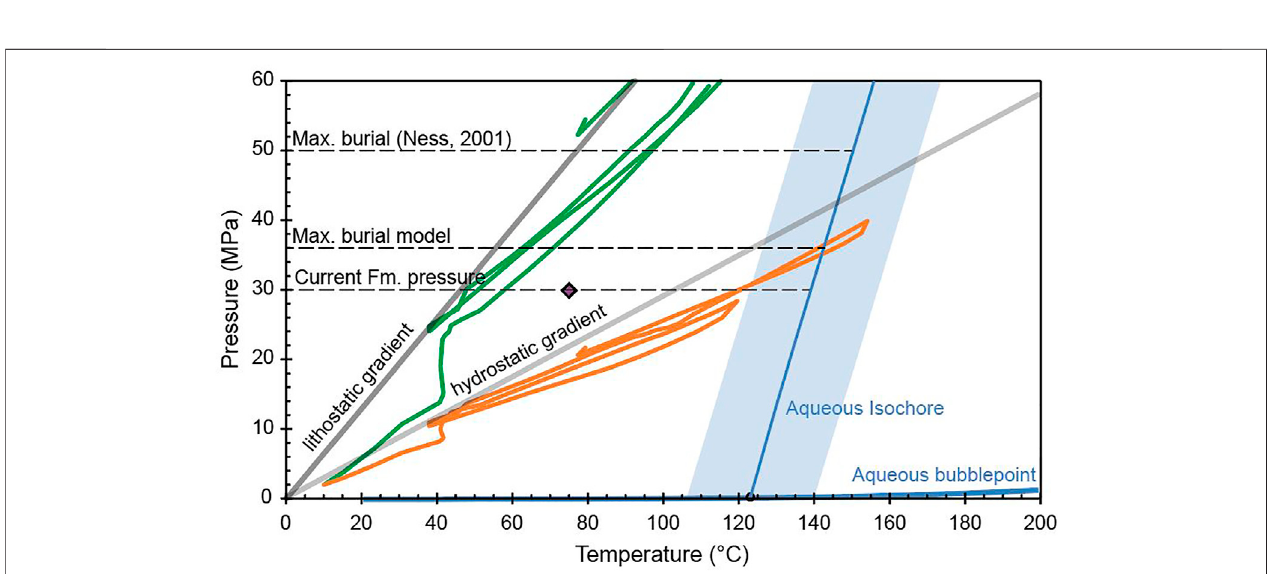
FIGURE 10 | Pressure-temperature modeling for aqueous fl uid inclusions. Aqueous bubblepoint curve calculated based on a measured salinity of 19.6% NaCl equiv. using the Aq_NaCl program (Bakker, 2018). Average aqueous isochore shown as dark blue line with minimum and maximum measured Th + Tm values de fi ning light blue envelope, all values calculated using Aq_NaCl program. Green and orange lines are lithostatic and hydrostatic gradients respectively, derived from a burial historymodelforthiswell( Figure11 ).Greylithostaticandhydrostaticgradientscalculatedusingadepth-pressuregradientof10.18 kPa/mandalocalgeothermal gradient of 35 ° C/km (Weides and Majorowicz, 2014) based on modern conditions. Maximum burial pressure from two different burial history models are shown as grey dashed in, see text for details.